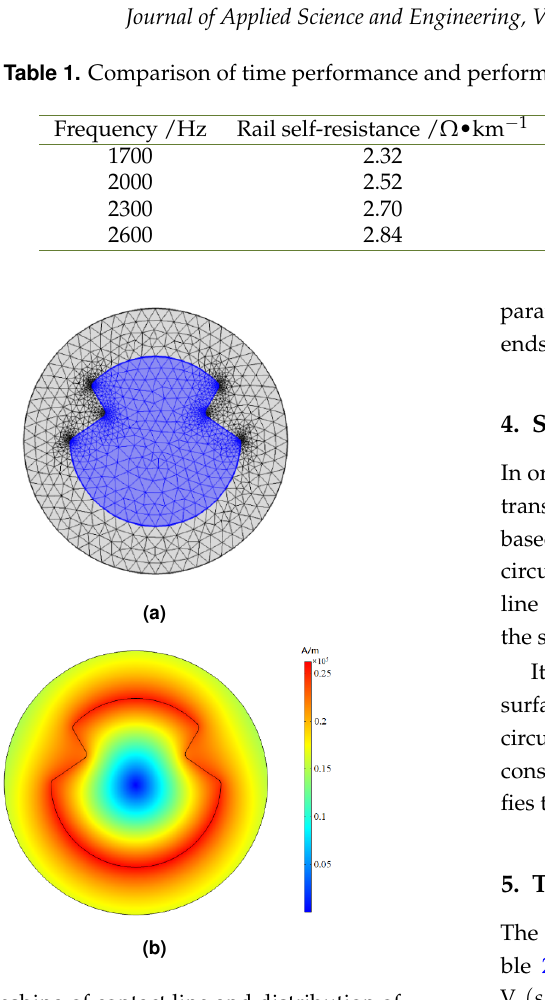
Fig. 5. Meshing of contact line and distribution of magnetic induction intensity.